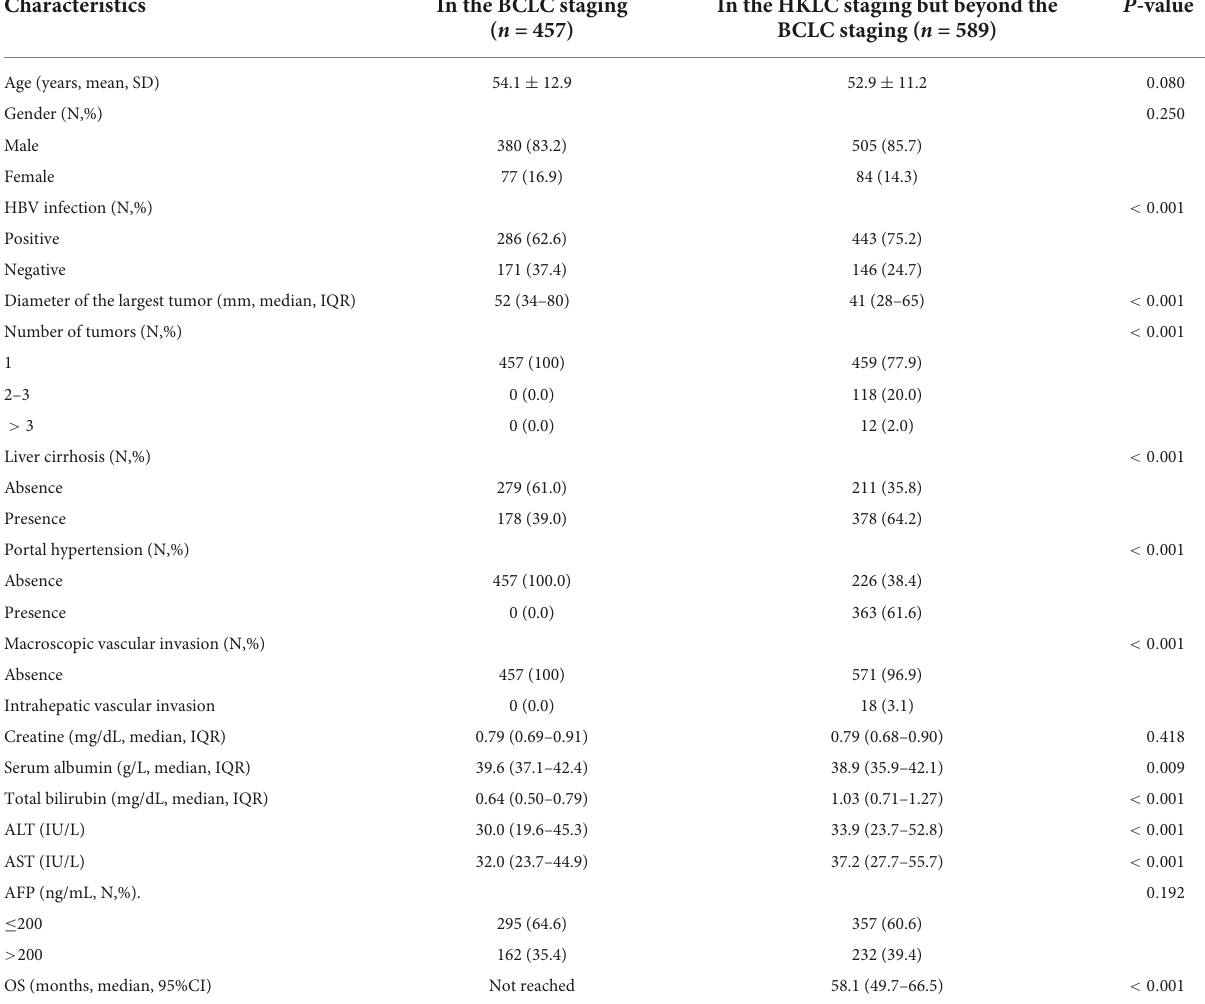
TABLE 3 Baseline characteristics between IPLRs in the BCLC staging and IPLRs in the HKLC staging but beyond the BCLC staging. Characteristics In the BCLC staging ( n =